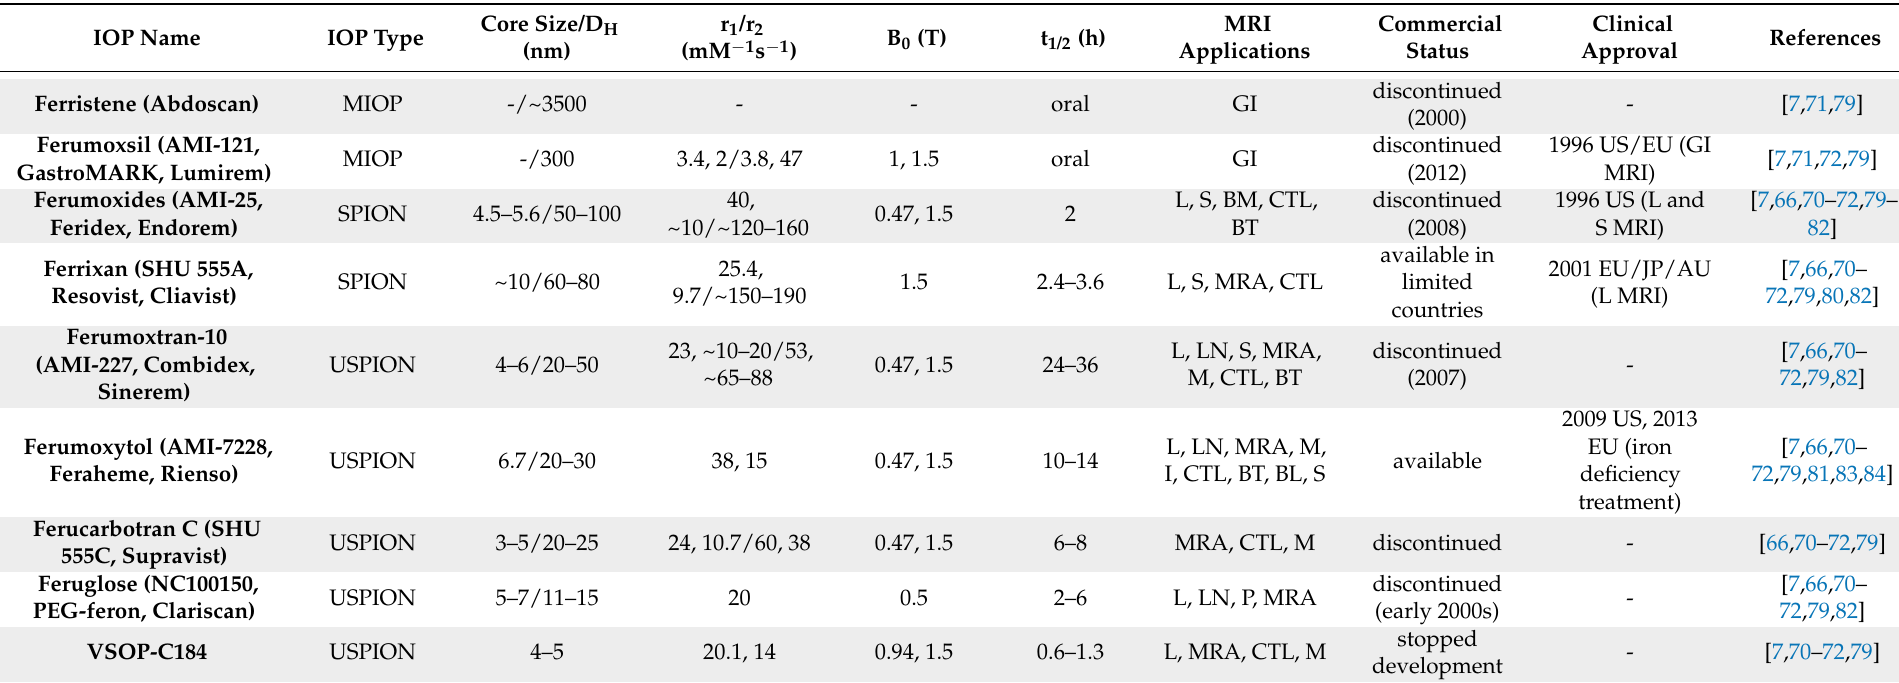
Table 1. Commercial iron oxide particles for clinical magnetic resonance